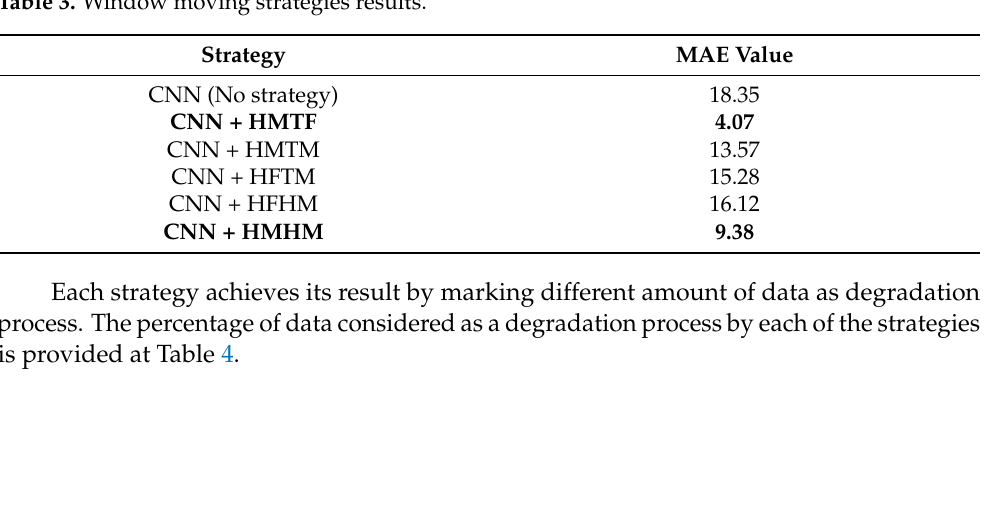
Table 3. Window moving strategies